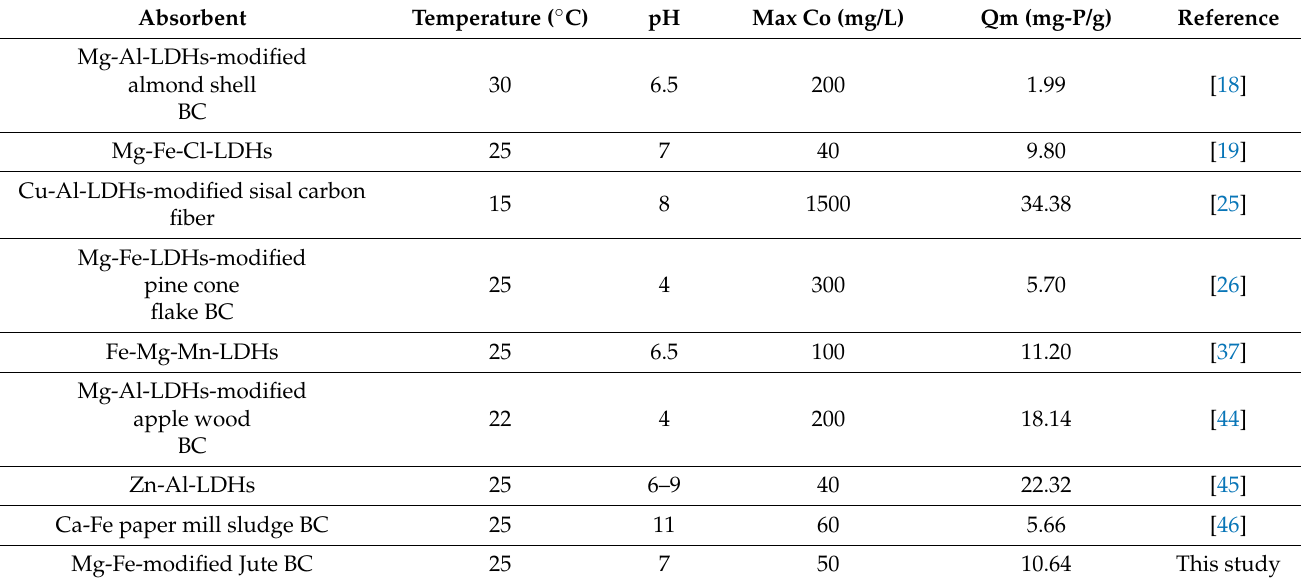
Table 3. Comparison of phosphate adsorption capacity.